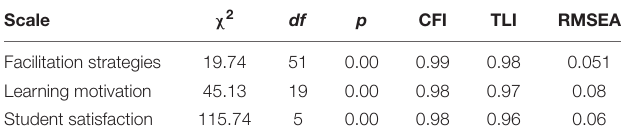
TABLE 2 | CFA results for the